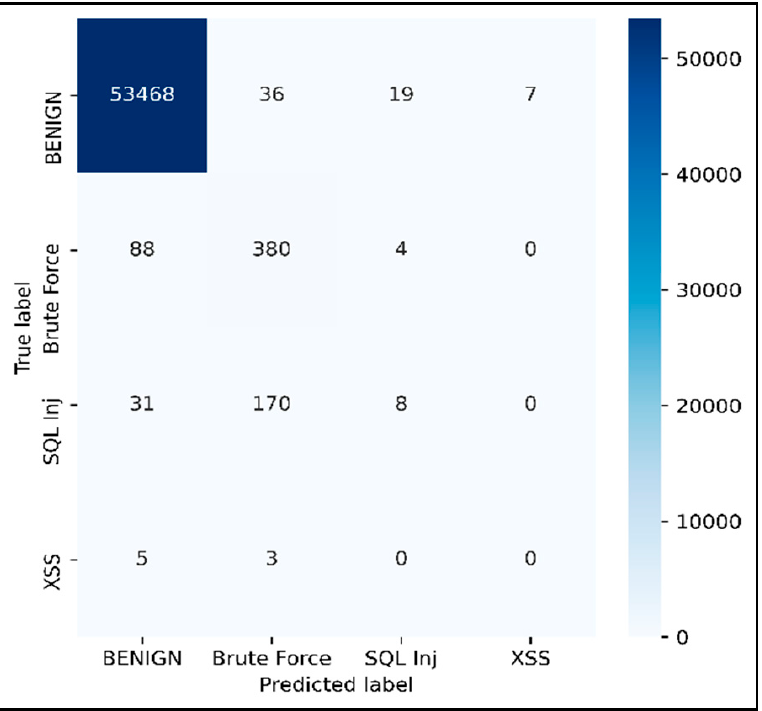
Figure 10. Thursday morning confusion matrix